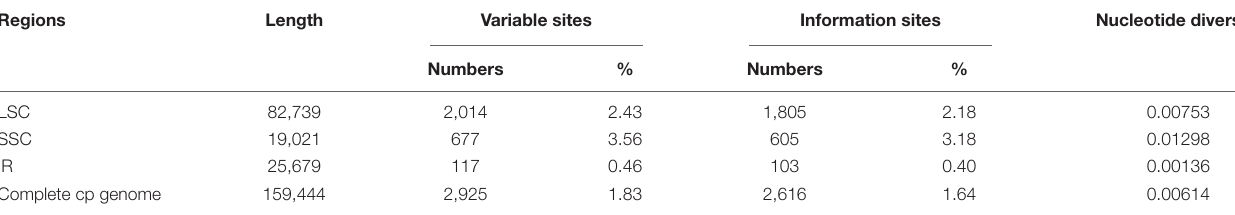
TABLE 2 | Analyses of variable sites in chloroplast genomes of Phytolacca .